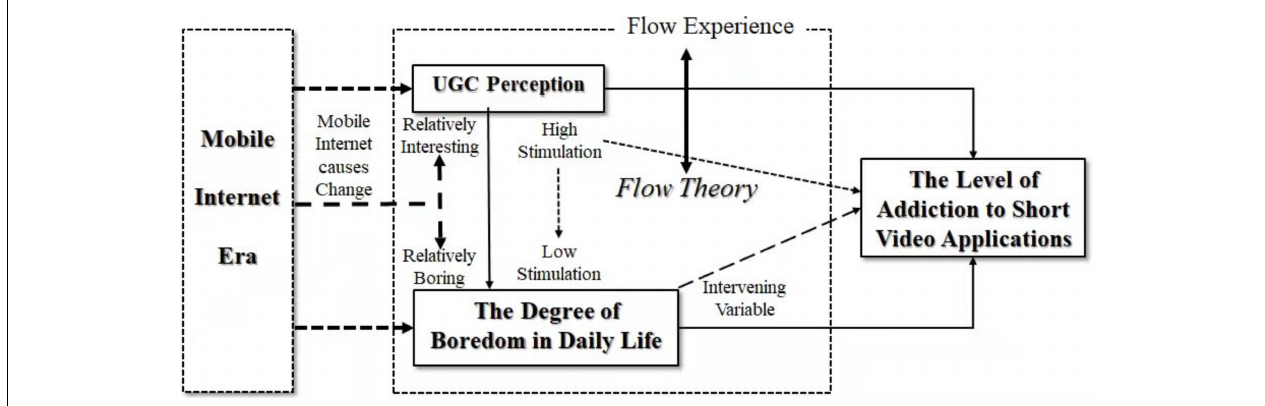
FIGURE 1 | Theoretical model of adolescent addiction to short video